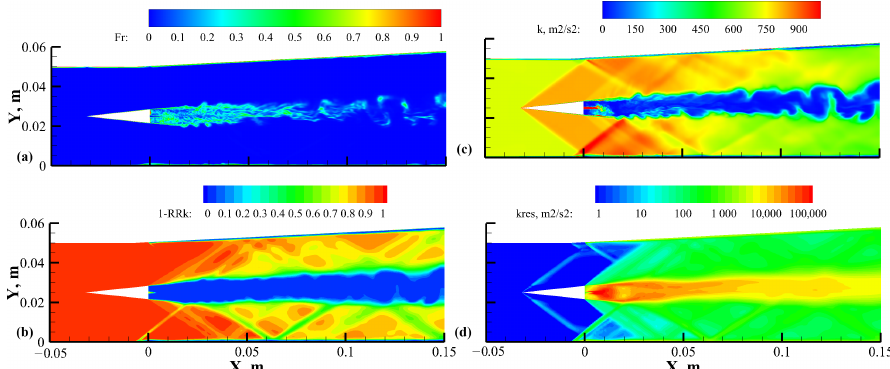
Figure 24. Contours of ( a ) resolution control function, ( b ) unresolved ratio of turbulent kinetic energy, ( c ) modeled turbulent kinetic energy, and ( d ) resolved turbulent kinetic energy from case M2 at the spanwise central